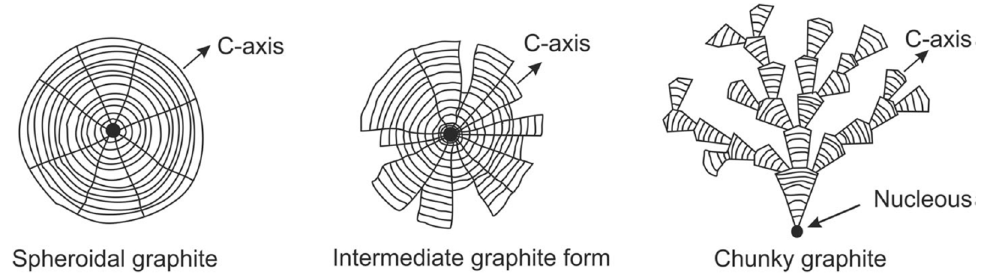
29 of 39 Figure 38. SEM images of chunky graphite: ( a ) Chunky graphite (CHG) growing from a common source in a heavy casting, reproduced from [130,133] with permission from Springer; ( b ) degenerated graphite assembly in Si solution- strengthened high Si SG iron, reproduced from [130,134] with permission from Springer. The schematic representation of the sequence of graphite degeneration from SG to CHG presented in Figure 39 captures two important elements of the morphology of CHG, the radial growth and the interconnection of various segments. Interconnection is always seen, but radial